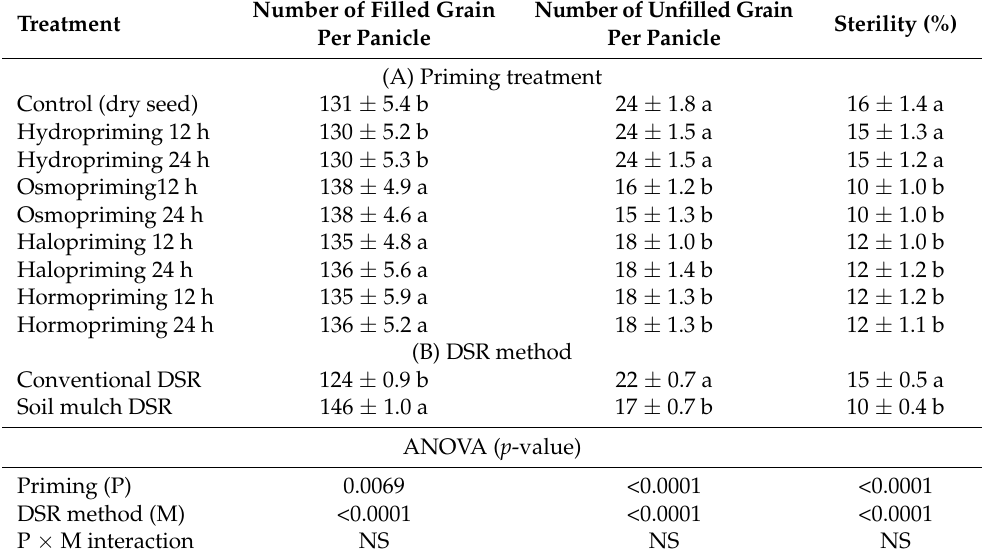
Table 11. Yield attributes (filled and unfilled grains per panicle and sterility %) of rice as affected by different seed priming and DSR establishment methods during 2019 at Ludhiana, India.